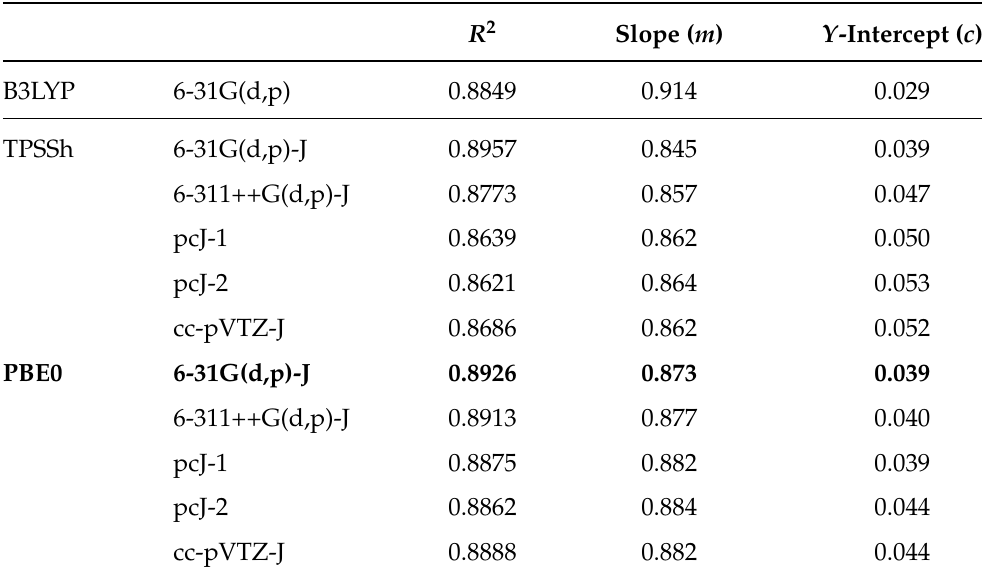
Table 4. Calculated R 2 , slope, and intercept values with reference to B3LYP/6-31G(d,p) values. All results were generated using the PCM solvation